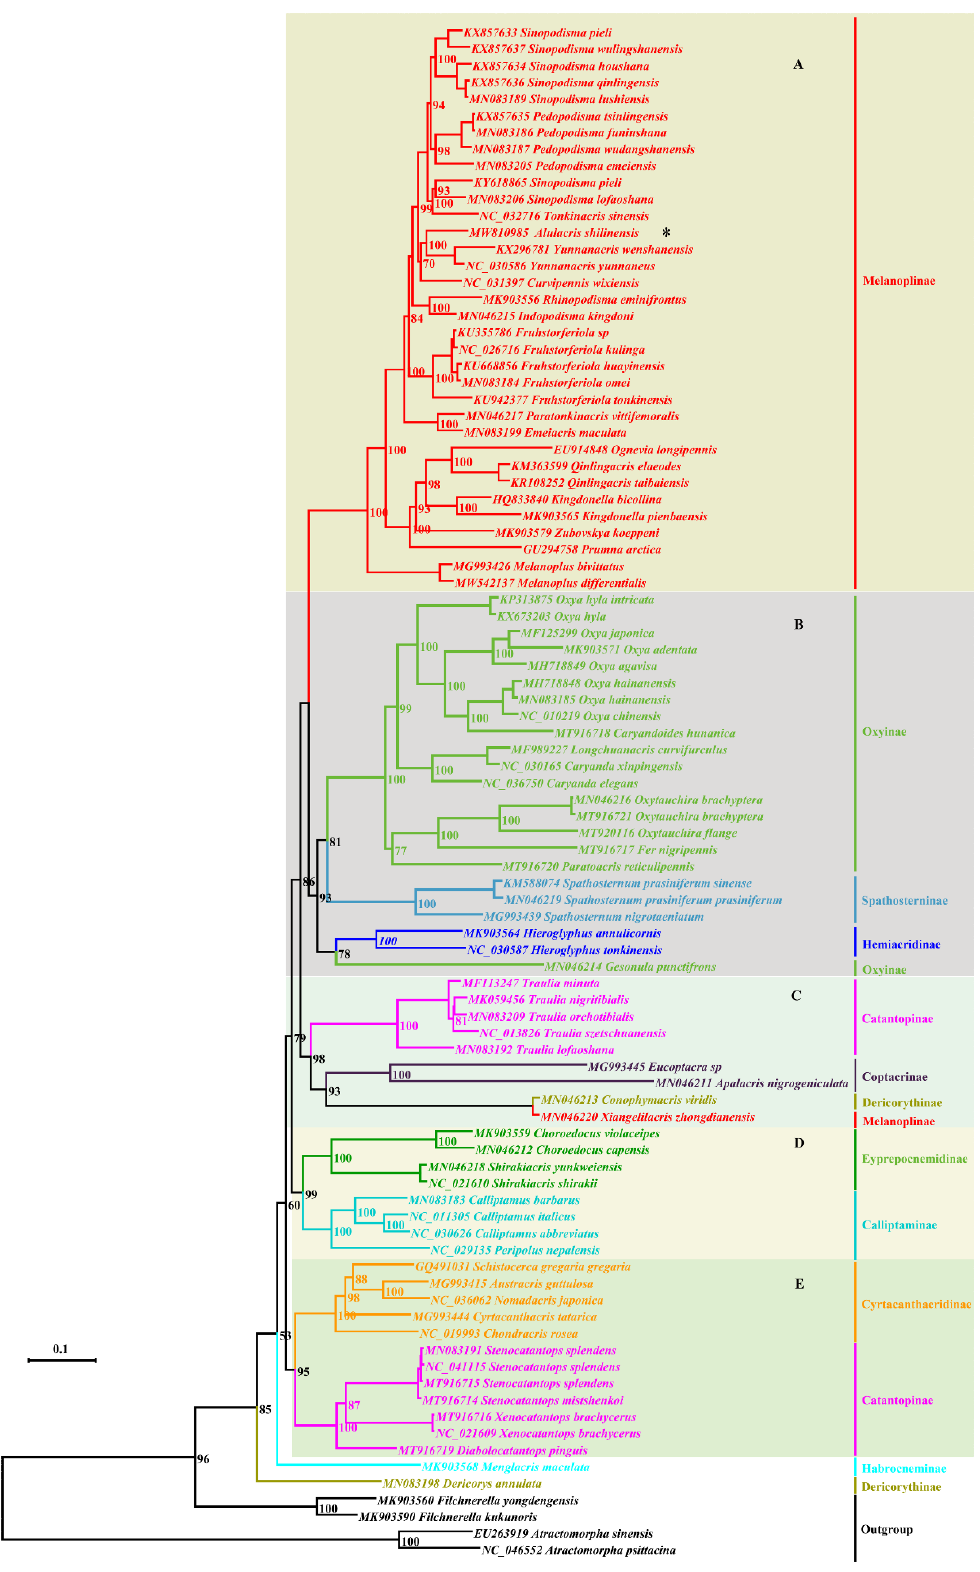
Figure 1. Phylogenetic tree reconstructed from the sequences of the 13 mitogenome PCGs (protein-coding genes) using maximum likelihood. The asterisk indicates the species Alulacris shilinensis . ( A ). Melanoplinae (excluding the genus Xiangelilacris ). ( B ). Oxyinae+Spathosterninae+Hemiacridinae. ( C ). Coptacrinae+ Traulia + Conophymacris + Xiangelilacris . ( D ). Eyprepocnemidinae+Calliptaminae. ( E ). Cyrtacanthacridinae+Catantopinae.